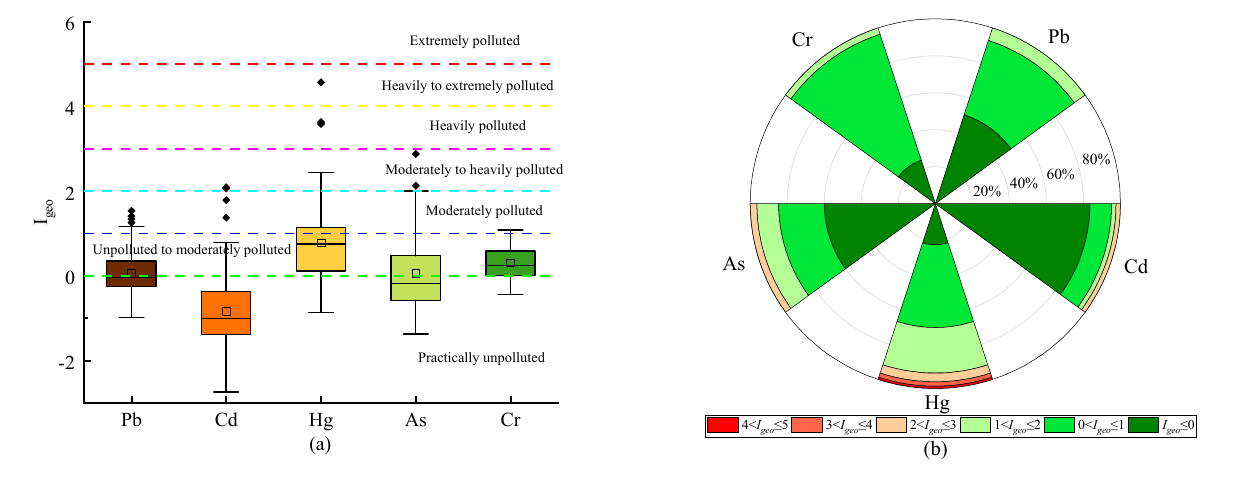
Figure 2. Results of the HMs geoaccumulation index. ( a ) Boxes represent 25th, 50th (median), and 75th percentiles and whisker minimum and maximum values. Mean values ( □ ); and outliers ( ◊ ). ( b ) Percentage of the I geo at different pollution levels.